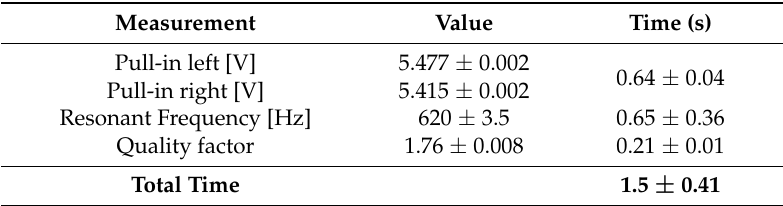
Table 1. Measurement repeatability for 2600 samples (mean ± std).